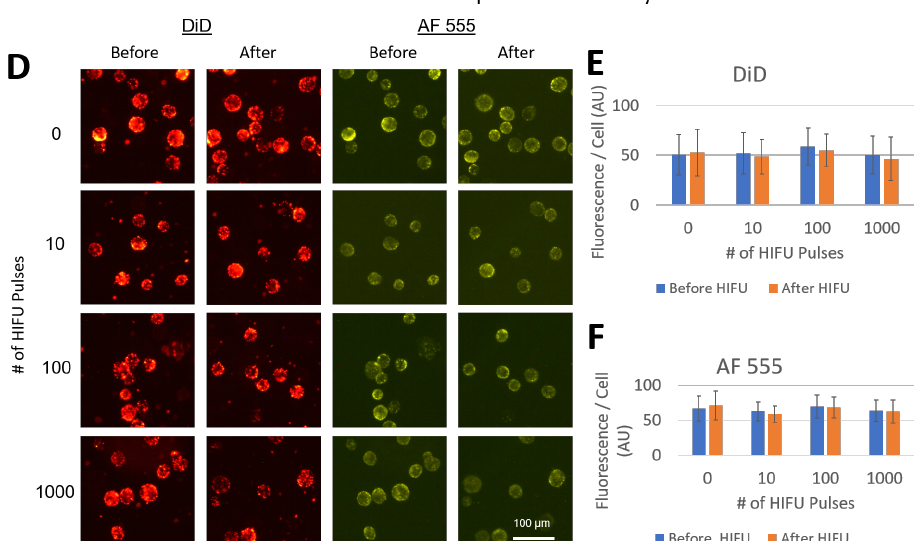
Figure 5. The PFHnD-Abs were subjected to either 0, 10, 100, or 1000 vaporization-recondensation cycles using HIFU before being incubated with cells to test the effects of activation on cellular binding. ( A ) Fluorescent images of cells after incubation with the pre-activated PFHnD-Abs. ( B ) The mean fluorescence per cell in the DiD channel showed no statistically significant difference except for two isolated cases (* p < 0.01) using the Mann-Whitney Test. ( C ) The mean fluorescence per cell in the AF 555 channel resulted in isolated cases of statistically significant differences using the Mann-Whitney test (* p < 0.01). ( D ) Before and after images of cells with PFHnD-Abs bound to the surface before HIFU activation in the DiD and AF 555 channels. ( E , F ) The mean fluorescence per cell before and after HIFU activation did not show any statistical difference in the DiD and AF 555 channel